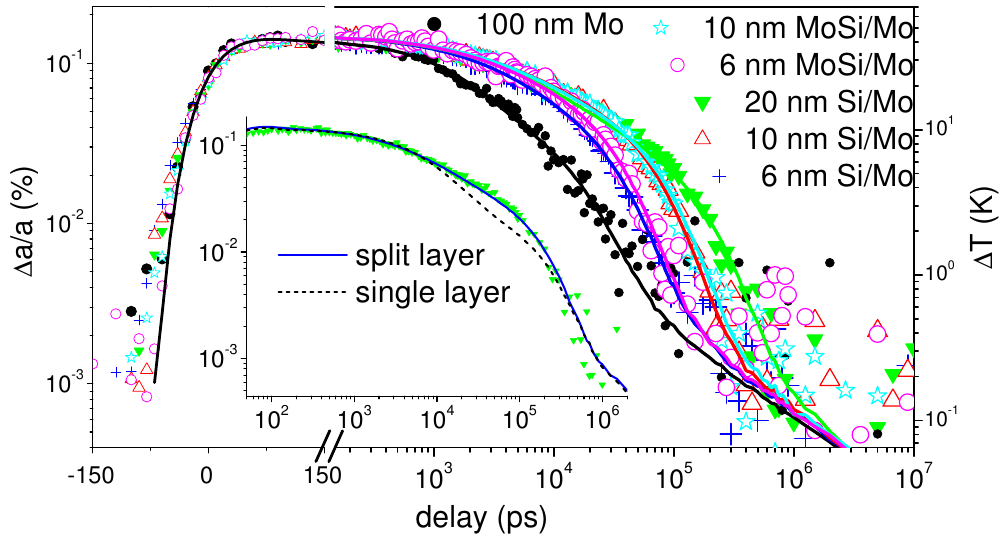
Figure 7. Lattice expansion of the gold layer on top of Si-Mo multilayer samples, as well as a 100 nm molybdenum layer on silicon substrate (black circles). The lines are results of a best fit with the heat transfer model with an effective thermal conductivity modeled independently for two splitted parts of the stack. The inset compares the two-layer fit with a single-layer